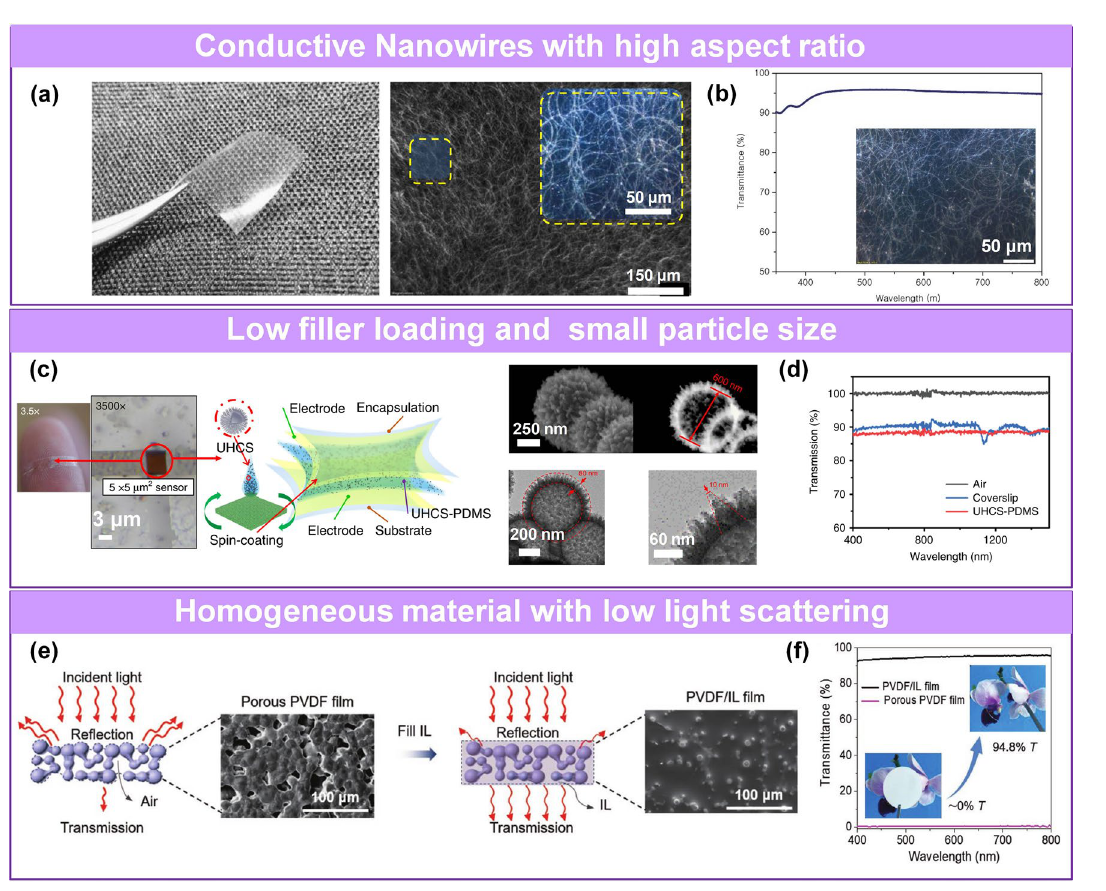
Fig. 11 Pressure sensors with high transparency. a Transparent Ag NP electrode with high aspect ratio and b transmittance [93]. Copyright (2019) The Authors. c Photo, TEM image and d transmittance of transparent pressure sensors based on small size particles with low fill content [83]. Copyright (2020) The Authors. e Transparent transition mechanism of ionic liquids filling with porous film. f Comparison for the transmit- tance of ionic liquids before and after filling [235]. Copyright (2020)